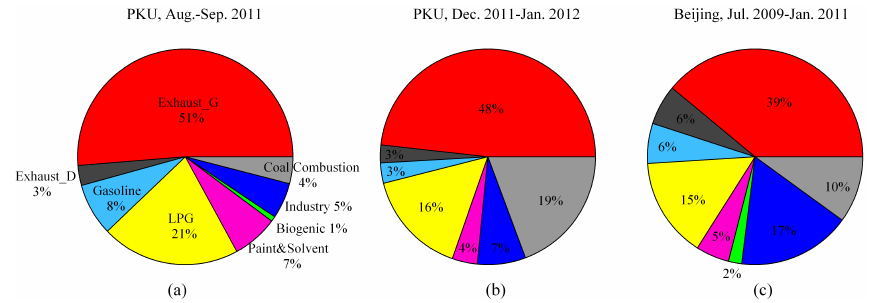
Figure 12. Comparison of the average relative contributions of different sources to ambient NMHCs at the PKU site during (a) summer, (b) winter, and (c) those for 27 sites in Beijing from July 2009 to January 2011.